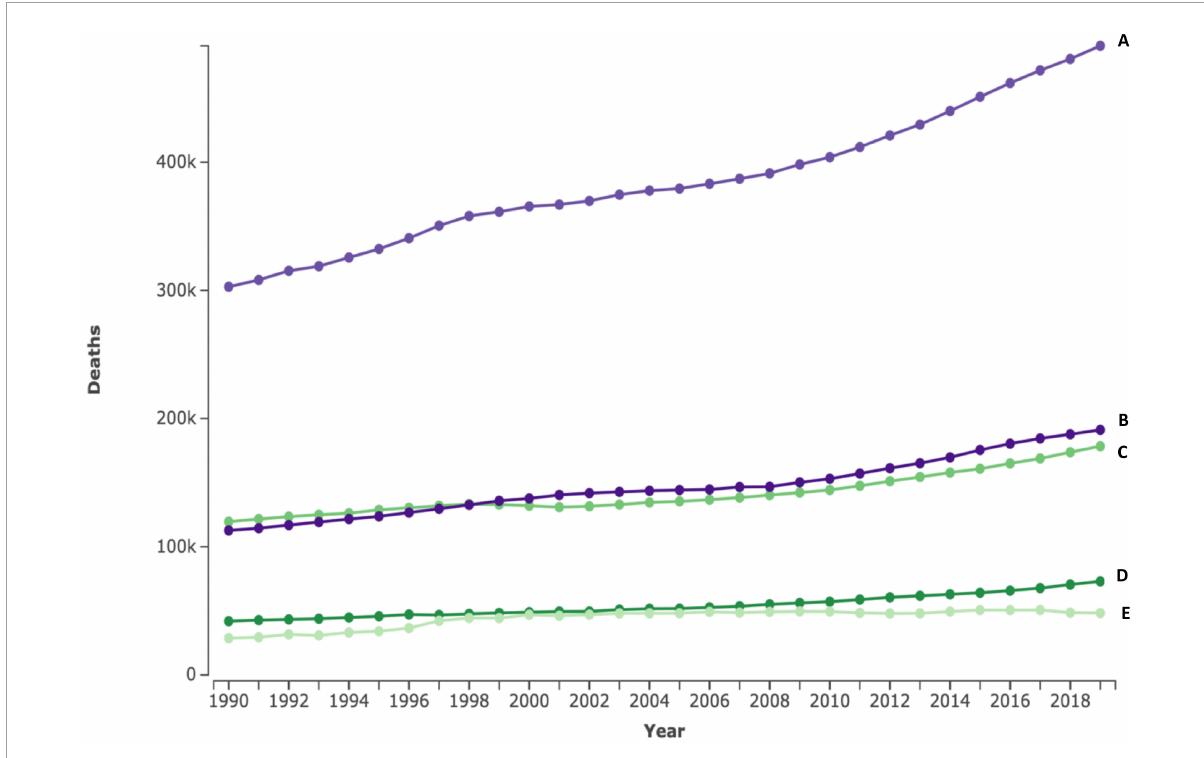
FIGURE1 Absolute number of cardiovascular deaths in < 70 years for four SSA regions between 1990 and 2019. The top line represents the four Sub-Saharan African regions combined (A), Western (B), eastern (C), central (D), and southern (E) numbers in 100.000s. Figures extracted from the Institute for Health Metrics and Evaluation (IHME)